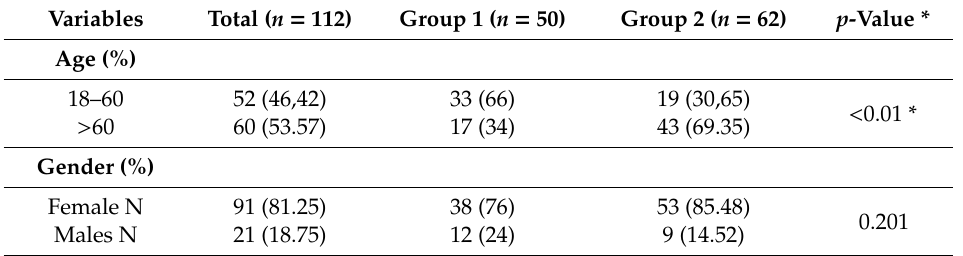
Table 1. Demographic data of study participants with OLP according to the clinical form of